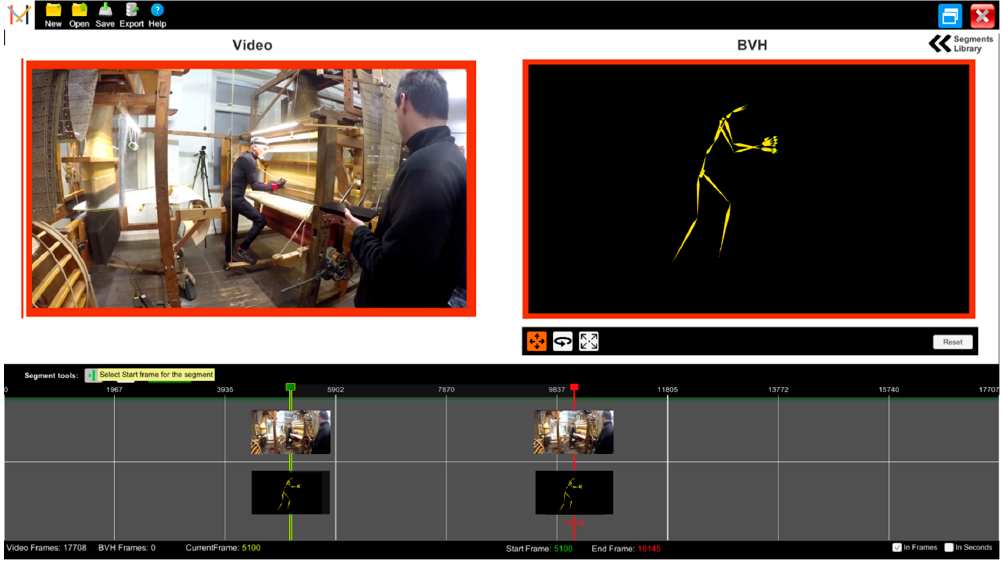
Figure 10. Screenshot of AnimIO version 4.0. Appl. Sci. 2020 , 10 , 7325